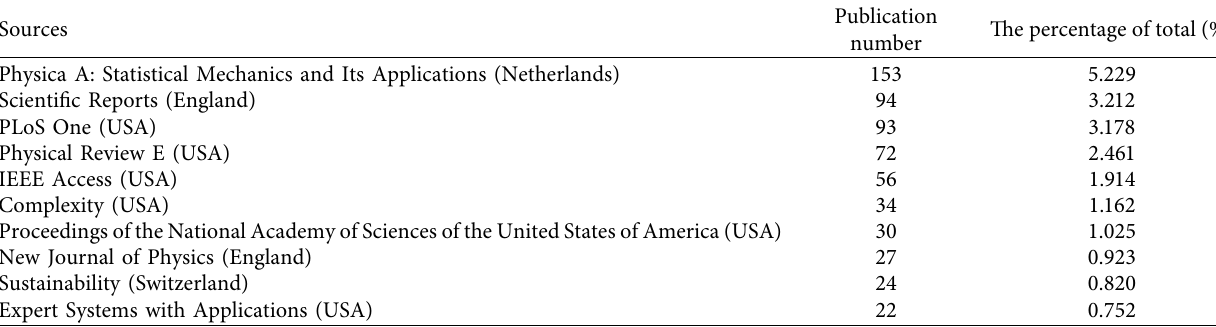
Table 2: Top 10 productive sources in the dynamic complex network research.